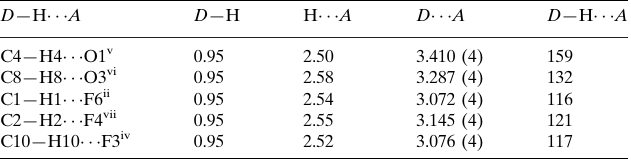
Hydrogen-bond geometry (A˚ , (cid:4) ).